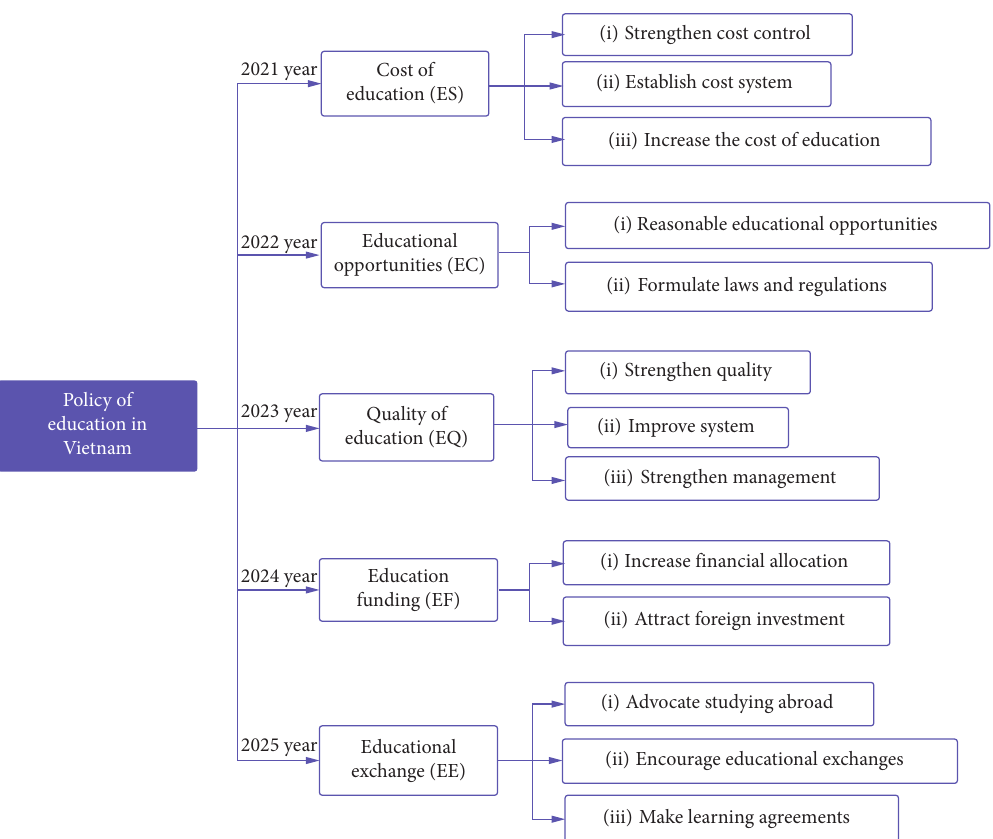
Figure 8: Timeline of Vietnam higher education policy